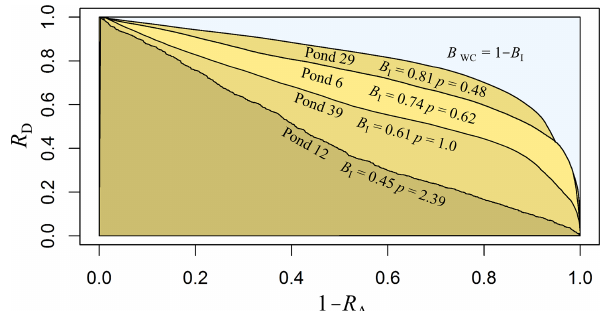
Figure 5. Bathymetric curves for ponds shown in Fig. 1. R D is rela- tive depth, R A is relative area, B I is the bathymetric integral, B WC is the bathymetric water capacity, and p is the optimum morphometry coefficient.